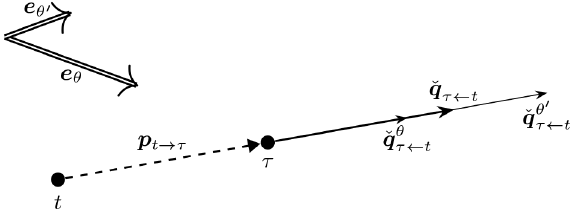
Figure 6. Illustration of how wind-direction-specific push-away pseudo-gradient vectors combine into an averaged push-away pseudo-gradient